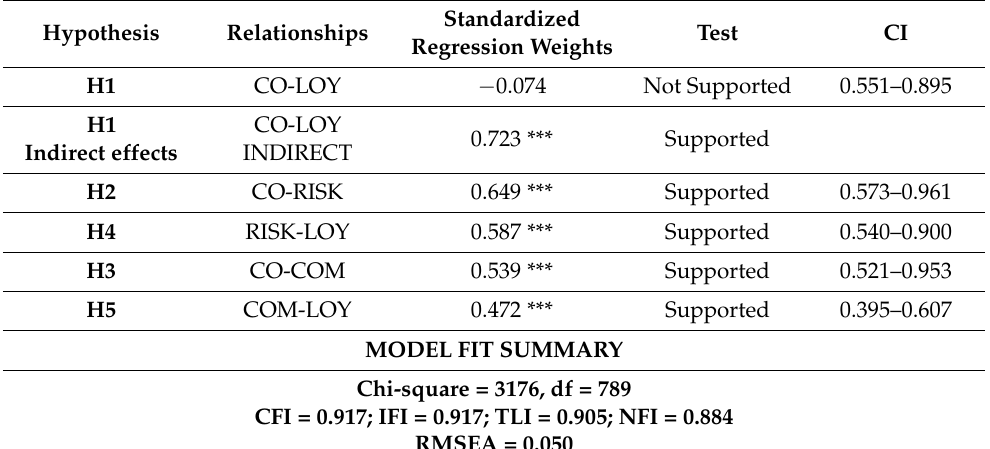
Table 10. Model fit summary and